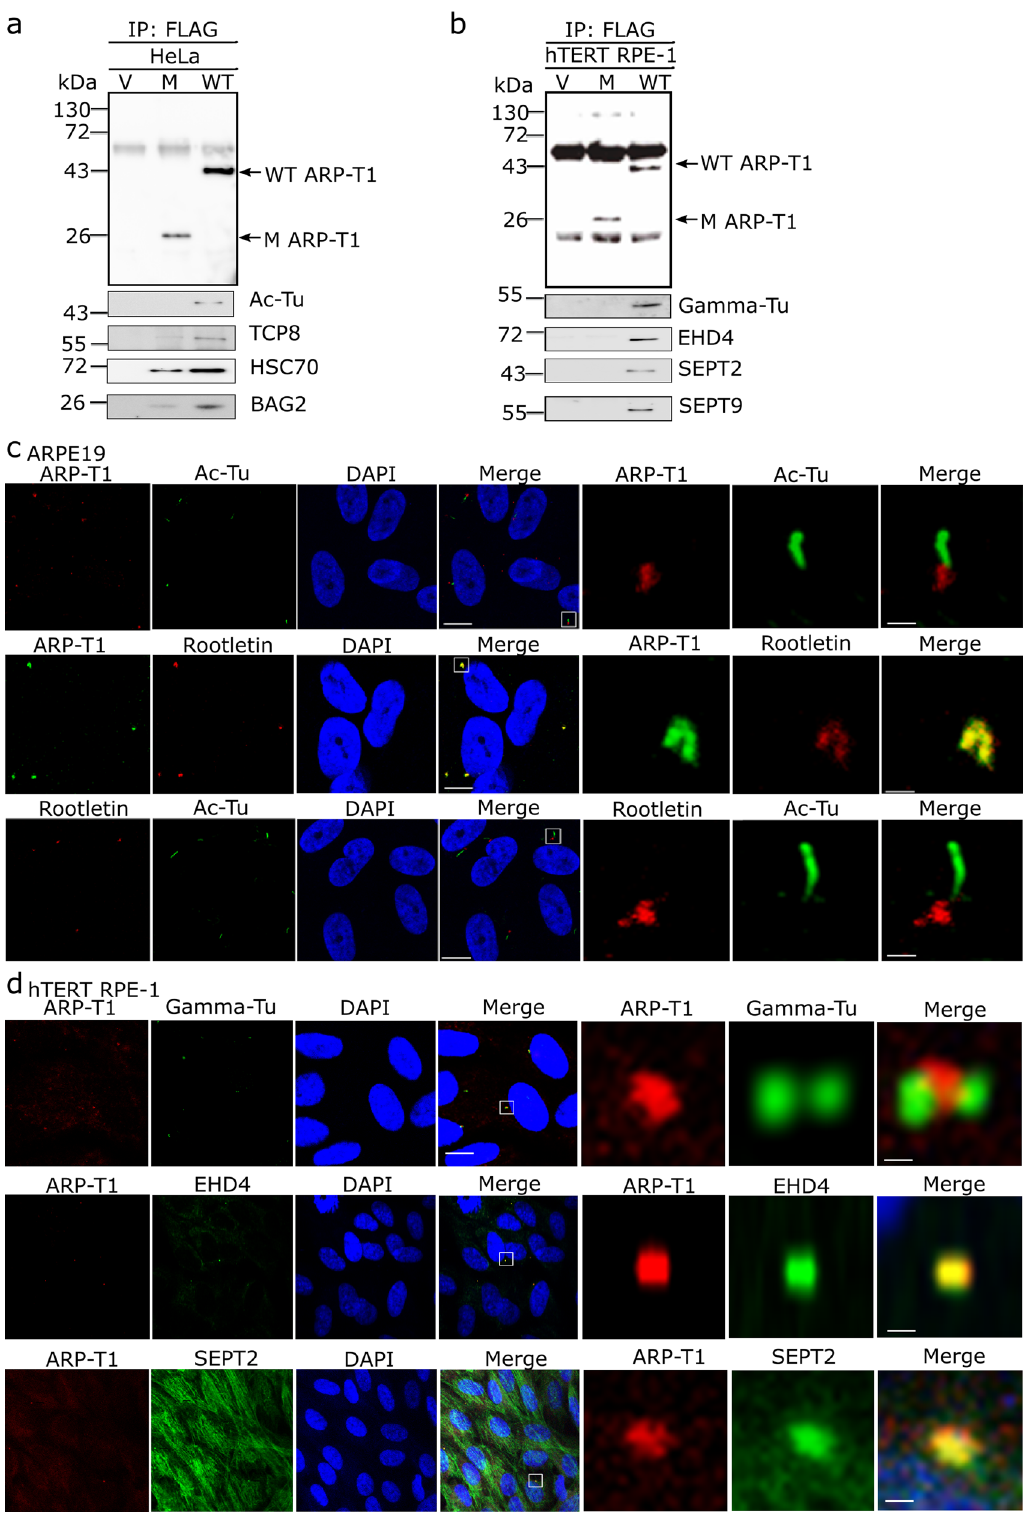
Fig. 3 ARP-T1 interacts with proteins involved in ciliary machinery. a , b HeLa ( a ) and hTERT-RPE1 ( b ) cells were transduced with lentiviral vectors, empty vector (V), ACTRT1 mutant (M) and ACTRT1 WT (WT), and immunoprecipitated (IP) with anti-FLAG monoclonal antibody M2-conjugated agarose, and analyzed by immunoblot with indicated antisera. c Immuno fl uorescence stainings of ARP-T1, acetylated-tubulin and rootletin in 35 days of serum-starved ARPE19 cells. Nuclei are stained with DAPI. Scale bar, 5 µ m. Higher magni fi cations of the boxed area are shown on right three panels. Scale bar, 1 µ m. d Immuno fl uorescence staining of ARP-T1, gamma-tubulin, EHD4, and septin 2 in 48 h of serum-starved hTERT-RPE1 cells. Nuclei are stained with DAPI. Scale bar, 5 µ m. Higher magni fi cations of the boxed area are shown on the right three panels. Scale bar, 1 µ